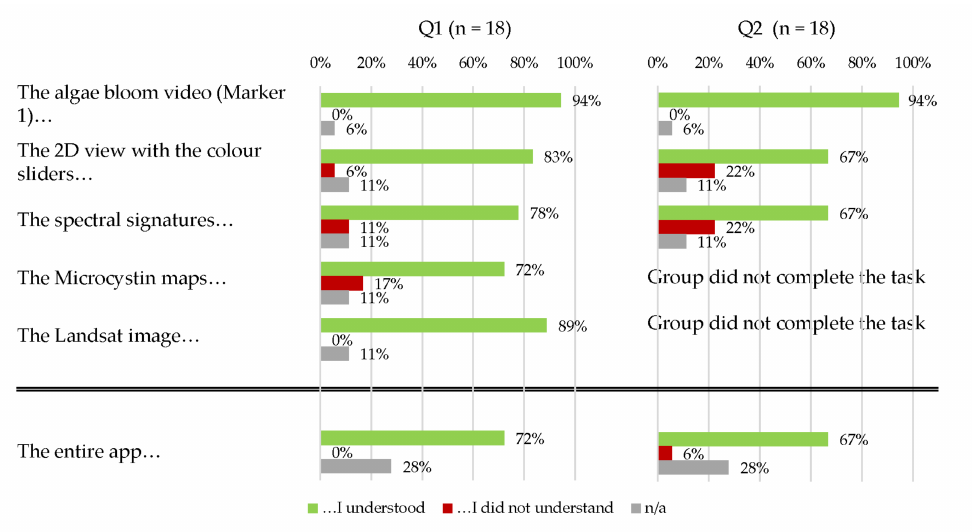
Figure 15. Subjective answers regarding the understanding of the app.